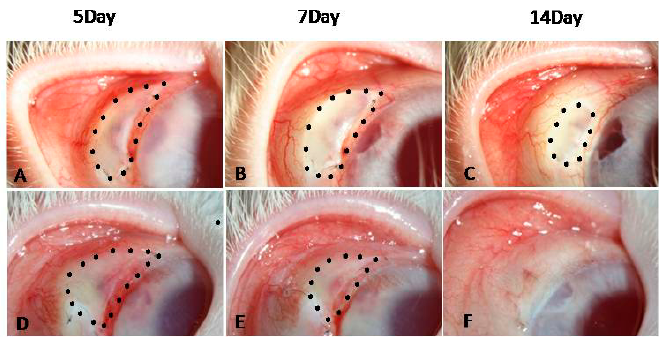
Figure 7. Filtering blebs on days 5, 7 and 14 after surgery. The bleb areas of the control ( A – C ) and DED ( D – F ) groups shrank gradually. On day 14, the blebs in the control group were localized, avascular, and cystic ( C ), while the blebs in the DED group were flat, scarred, and vascularized ( F ) (16 ×